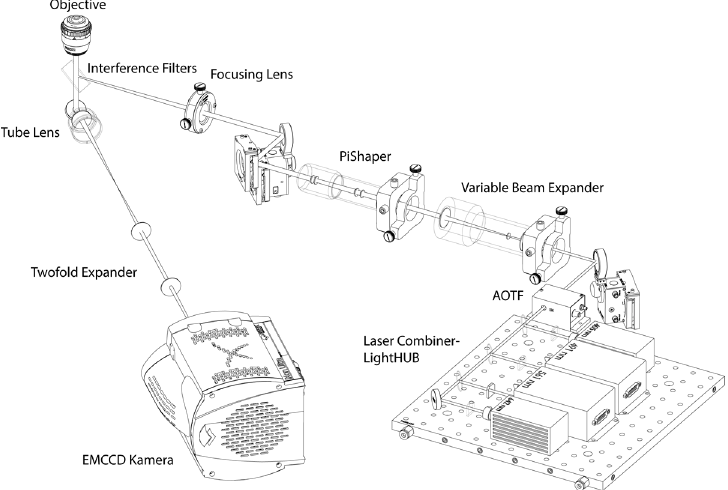
Figure 1. Schematic illustration of the localization microscope set-up.